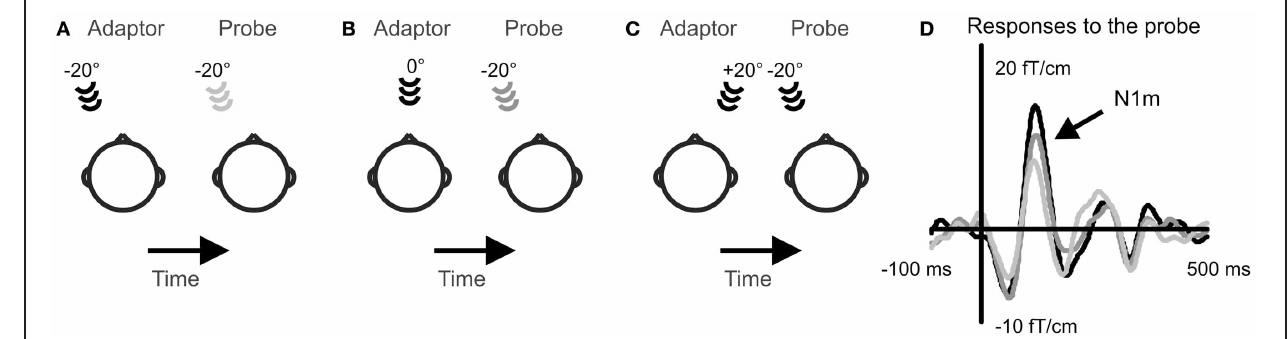
FIGURE 1 | Selectivity to sound source location in the human cortex was recorded with a stimulus-specific adaptation paradigm. A probe sound was presented to the left of the subject and adaptor sounds to the left (A) , in front (B) , and to the right (C) . Event-related fields were recorded to the probe sound. The